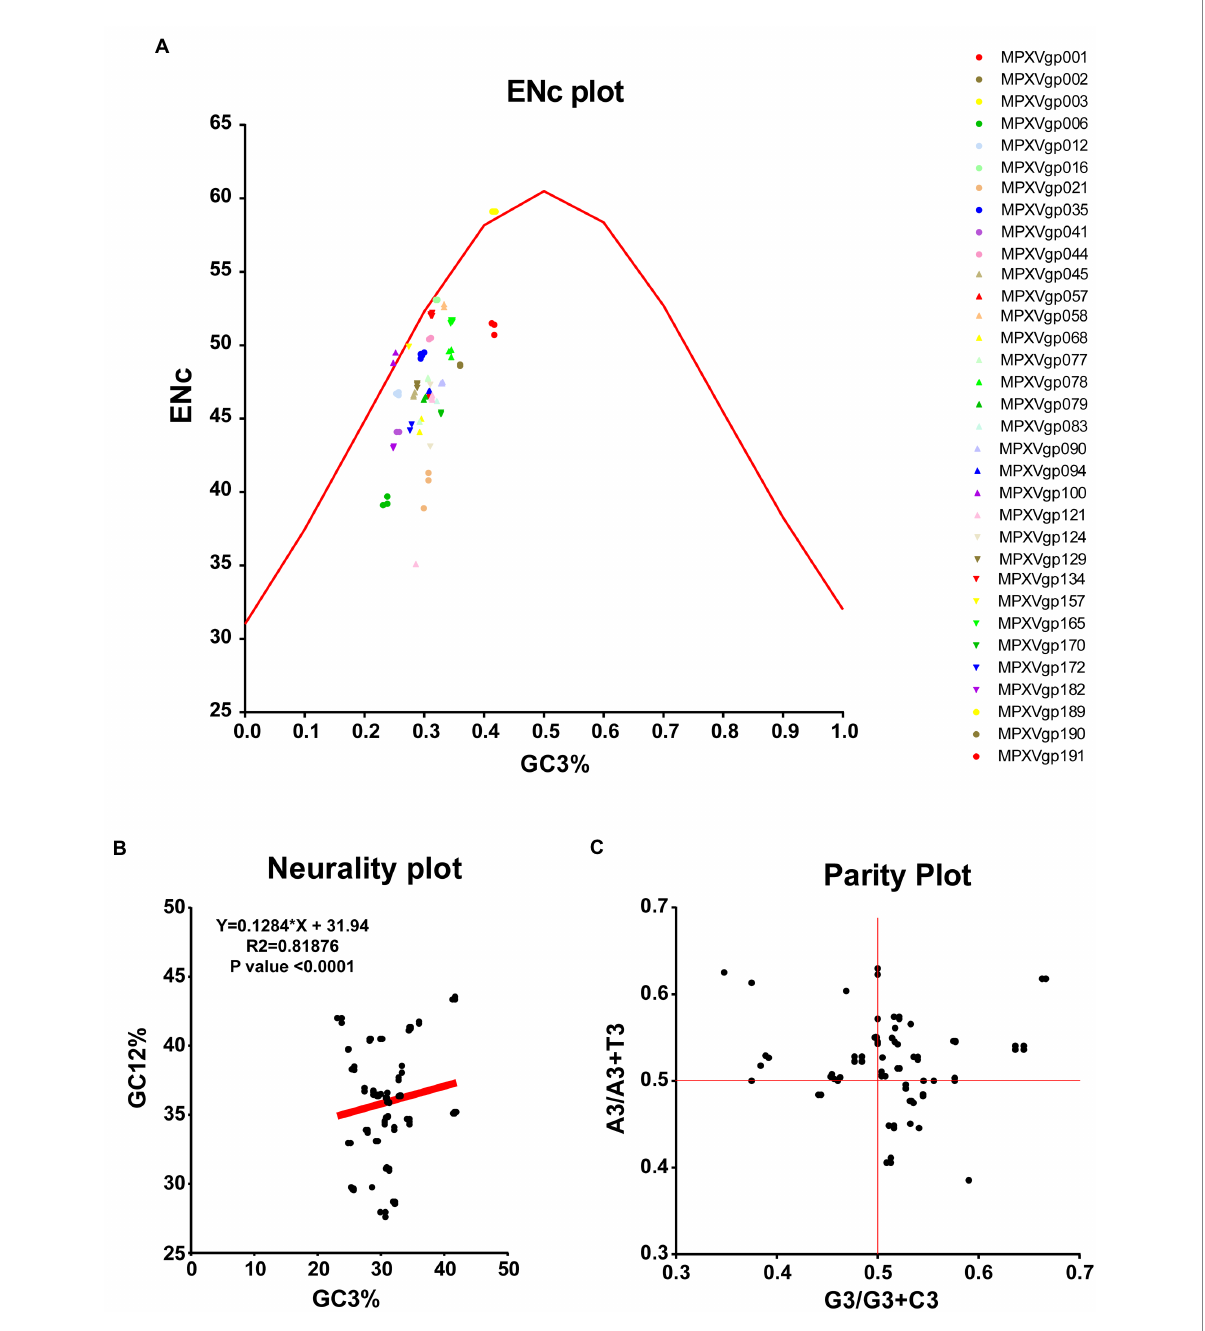
FIGURE 5 Selection and mutation pressure determining indices. (A) ENc-GC3s plot values for genes that displayed mutations in the Clade IIb-B.1lineages of viruses compared with NC_063383.1/ MT903340.1. More than 1,000 sequences from different lineages in Clade IIb were used, and details are provided in Supplementary Data S1. The ENc-GC3 values of each gene are given in Supplementary Data S3. (B) Neutrality plot values for genes that displayed mutations in the Clade IIb-B.1lineages of viruses compared with NC_063383.1/ MT903340.1. More than 1,000 sequences from different lineages in Clade IIb were used, and details are provided in Supplementary Data S1. The Neutrality plot values of each gene are given in Supplementary Data S3. (C) Parity Rule 2 (PR2)-bias plot values for genes that displayed mutations in the Clade IIb-B.1lineages of viruses compared with NC_063383.1/ MT903340.1. More than 1,000 sequences from different lineages in Clade IIb were used, and details are provided in Supplementary Data S1. The PR2-bias values of each gene are provided in Supplementary Data